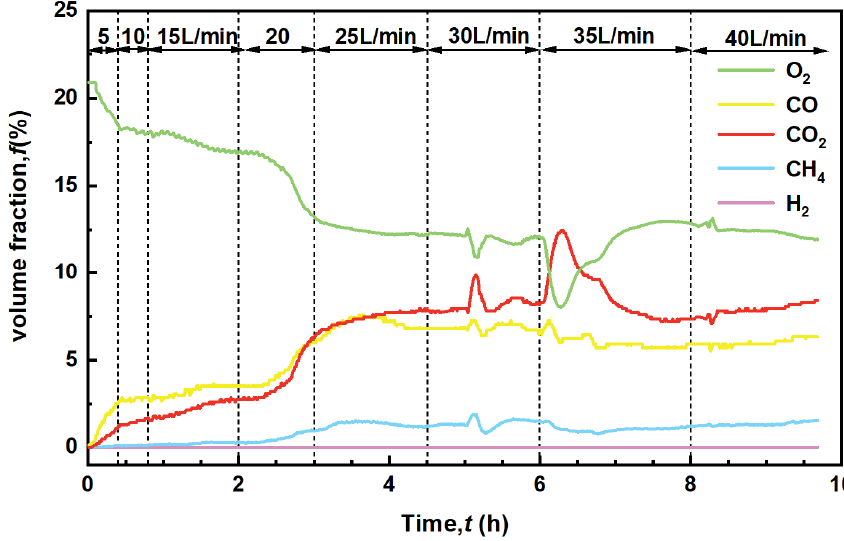
Figure 3. History of gas composition at outlet.